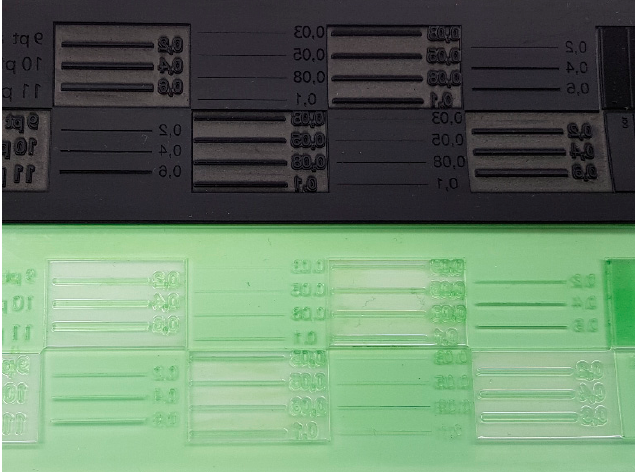
Figure 20. Line elements on EPDM plate (black) and photopolymer plate (green).